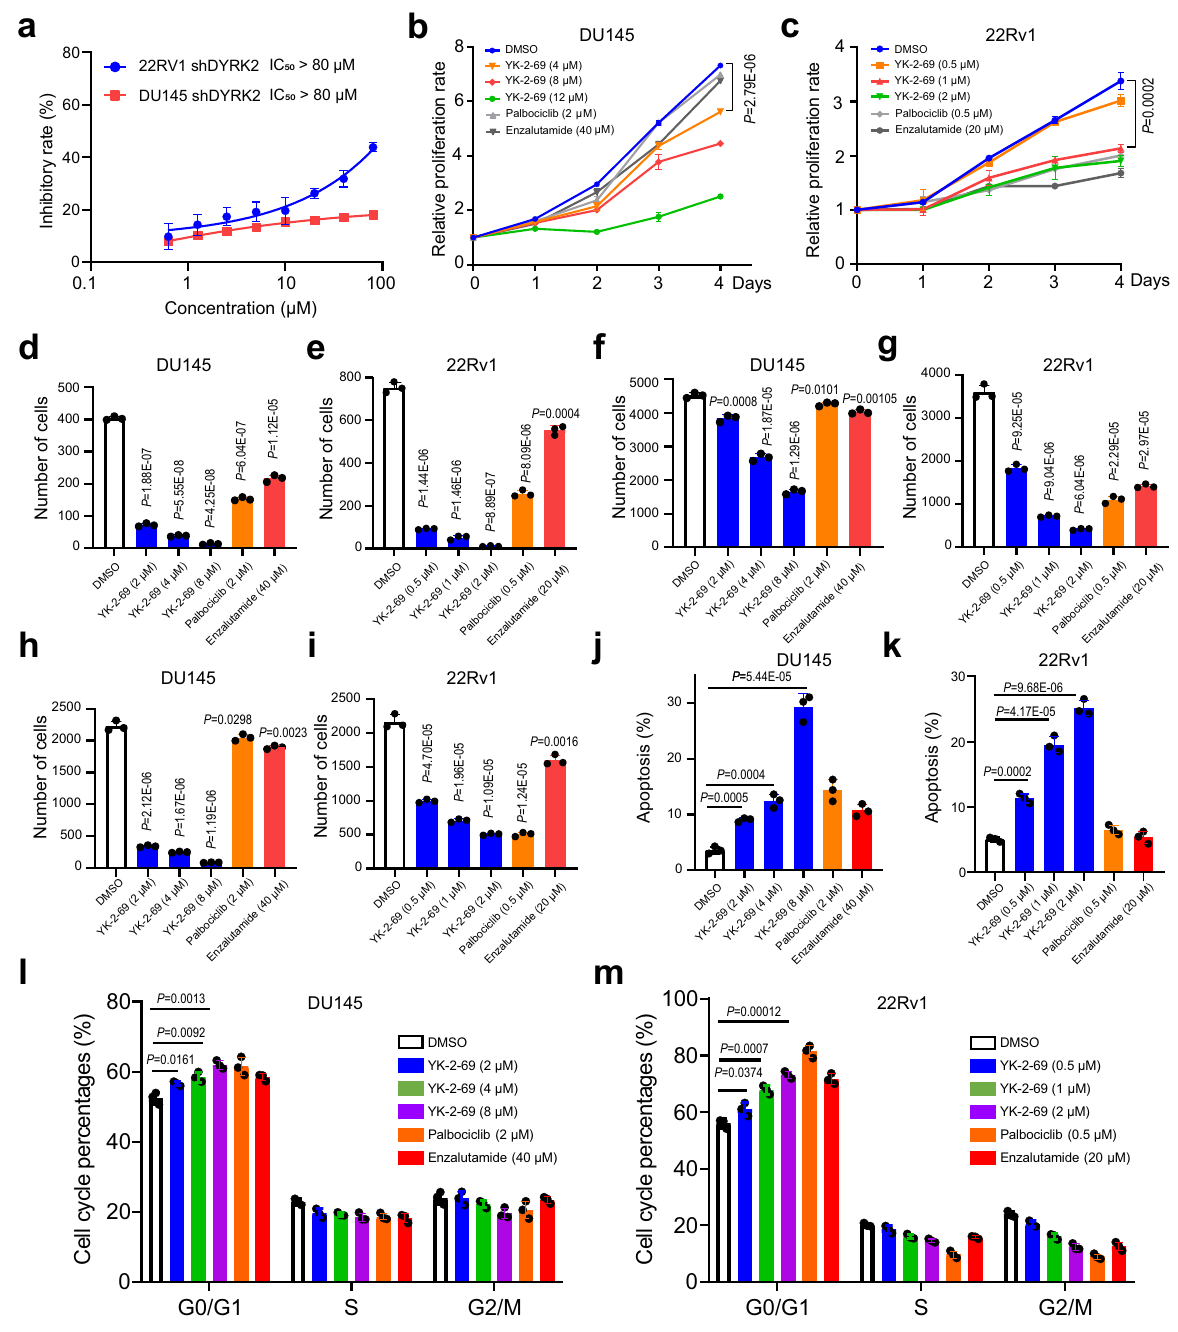
Fig. 5 YK-2-69 inhibited cell growth and metastasis and induced apoptosis in PCa cells. a Antiproliferative activity of YK-2-69 against DU145 and 22Rv1 shDYRK2 cells. Error bar, mean ± SD, n = 3. b , c Effects of YK-2-69 (4, 8, 12 µ M or 0.5, 1, 2 µ M), palbociclib (2 or 0.5 µ M), or enzalutamide (40 or 20 µ M) treatment on the DU145 ( b ) and 22Rv1 ( c ) cells viability during a 5-day course. Unpaired two-tailed Student ’ s t test. Error bar, mean ± SD, n = 3. d , e Quanti fi cation of DU145 ( d ) and 22Rv1 ( e ) cells colony numbers. Before being plated on the 24-well plate for colony formation, DU145 and 22Rv1 cells were treated with DMSO, YK-2-69 (2, 4, 8, or 0.5, 1, 2 µ M), palbociclib (2 or 0.5 µ M), or enzalutamide (40 or 20 µ M) for 48 h. Unpaired two-tailed Student ’ s t test. Error bar, mean ± SD, n = 3. f , g Quanti fi cation of migration ability of DU145 ( f ) and 22Rv1 ( g ) cells after treatment with DMSO, YK-2-69 (2, 4, 8 µ M or 0.5, 1, 2 µ M), palbociclib (2 or 0.5 µ M), or enzalutamide (40 or 20 µ M) for 48 h. Unpaired two-tailed Student ’ s t test. Error bar, mean ± SD, n = 3. h , i Quanti fi cation of invasion ability of DU145 ( h ) and 22Rv1( i ) cells after treatment with DMSO, YK-2-69 (2, 4, 8 or 0.5, 1, 2 µ M), palbociclib (2 or 0.5 µ M), or enzalutamide (40 or 20 µ M) for 48 h. Unpaired two-tailed Student ’ s t test. Error bar, mean ± SD, n = 3. j , k Apoptosis of DU145 ( j ) and 22Rv1 ( k ) cells after treatment with DMSO, YK-2-69 (2, 4, 8 or 0.5, 1, 2 µ M), palbociclib (2 or 0.5 µ M), or enzalutamide (40 or 20 µ M) for 48 h determined by fl ow cytometry. Unpaired two-tailed Student ’ s t test. Error bar, mean ± SD, n = 3. l , m Cell cycle phase distribution of DU145 ( l ) and 22Rv1 ( m ) cells after treatment with DMSO, YK-2-69 (2, 4, 8 or 0.5, 1, 2 µ M), palbociclib (2 or 0.5 µ M), or enzalutamide (40 or 20 µ M) for 48 h determined by fl ow cytometry. Unpaired two-tailed Student ’ s t test. Error bar, mean ± SD, n = 3. Source data are provided as a Source Data fi